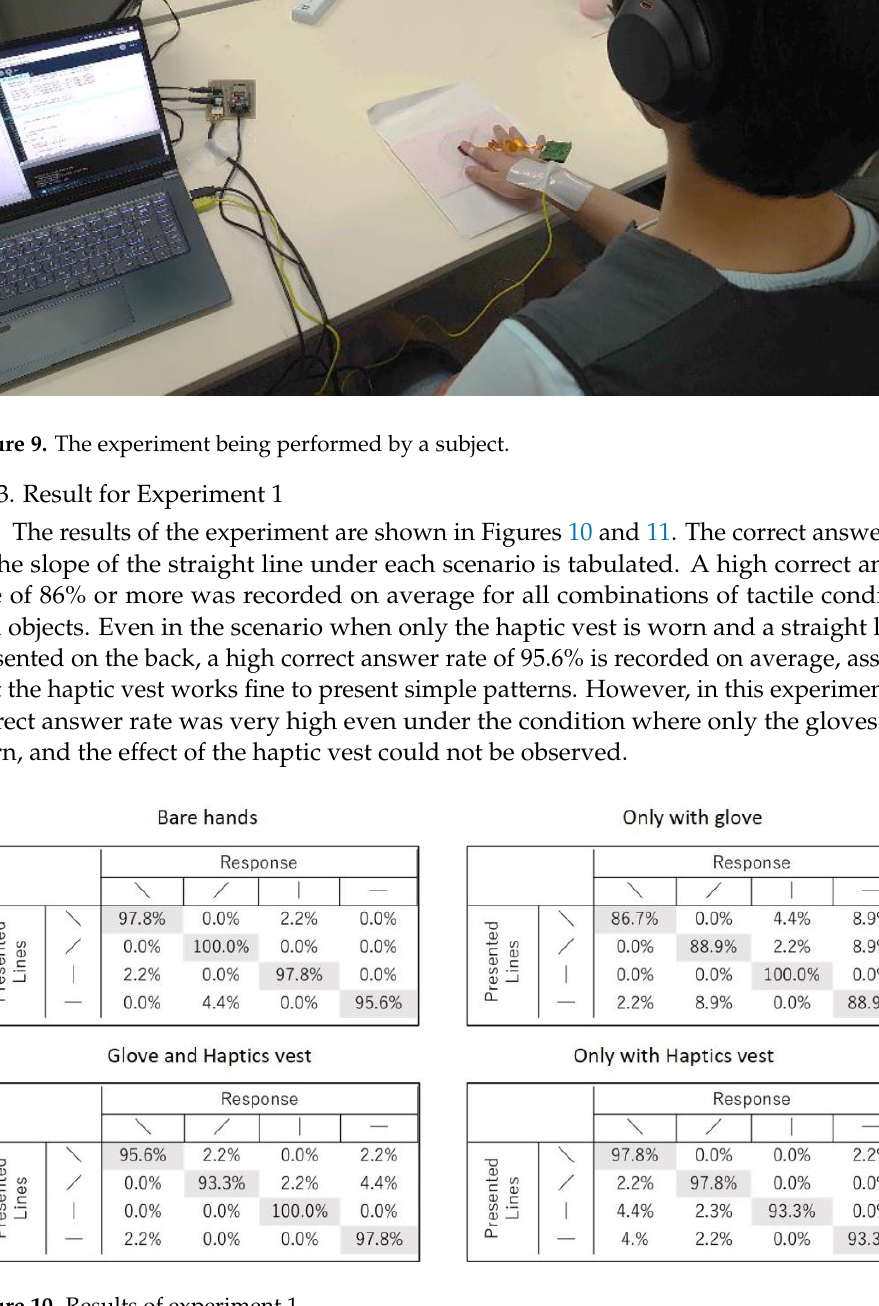
8 of 14 Figure 8. Output of sensor for the straight line at different angles. 4.1.1. Subject The experiments were performed by nine subjects with ages in the range of 21 – 42 (1 female, 8 males), all of whom were right-handed. 4.1.2. Experimental Environment and Procedure The experiments were carried out according to the four scenarios described at the beginning of this section. In addition, the slopes of the four types of straight lines were randomly presented five times each, for a total of 20 times (the total number of trials was 80). In each trial, one straight line object was placed on the desk, and after the subject touched the object, the angle of the perceived straight line was determined. The subject touched the straight line object only once. The subjects had to determine the angle of the straight line object within 5 s, and the correct answer rate for each straight line object was recorded.